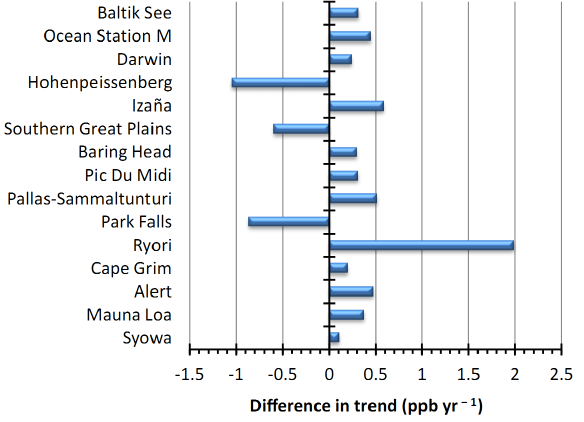
Fig. 6. Average difference between simulated and observed trends (ppb/yr) of CH 4 for Jan 1990 and Dec 2009 at GLOBALVIEW stations.